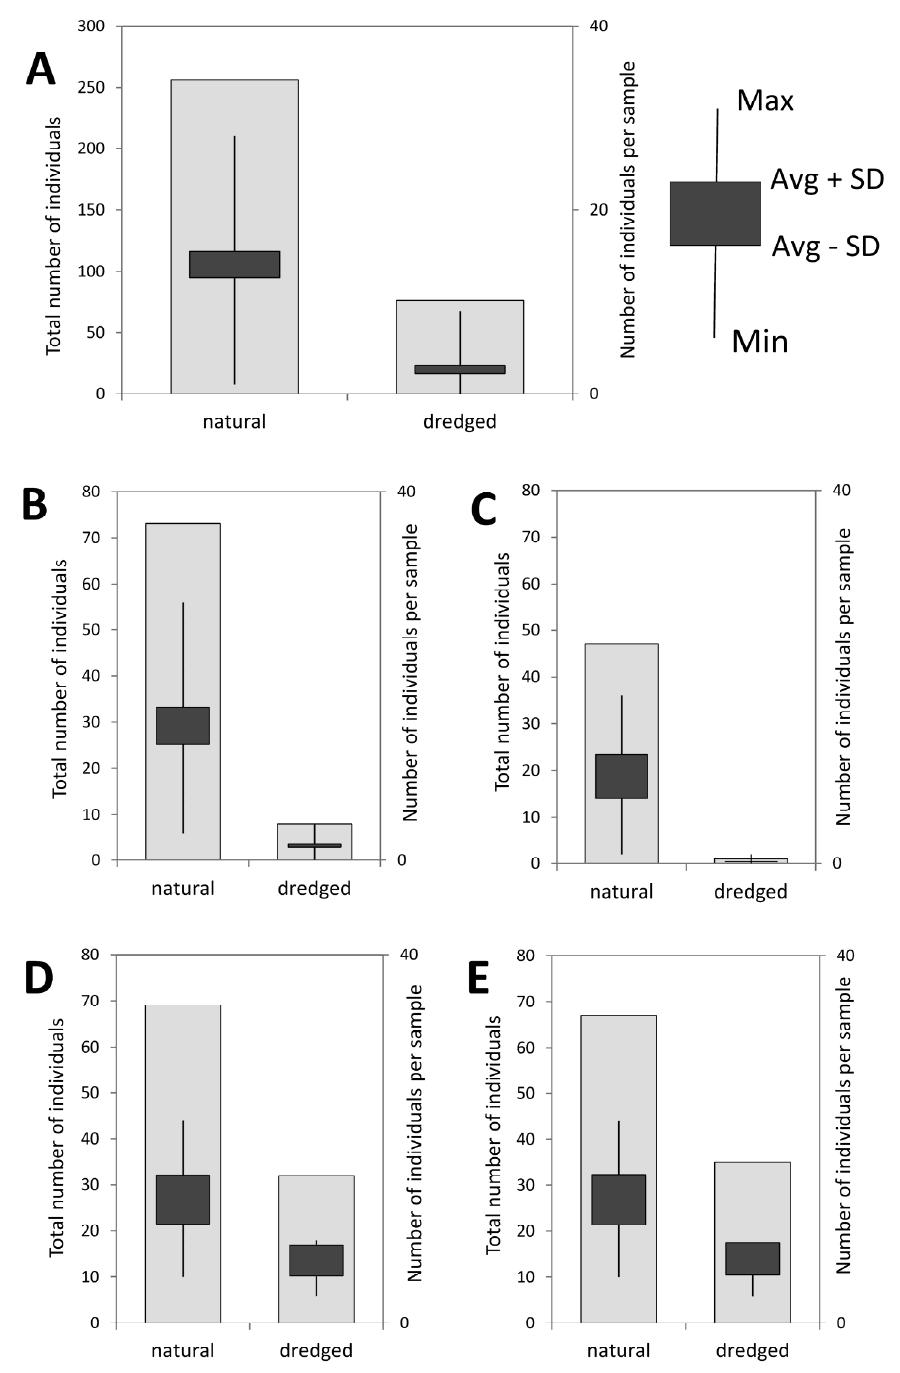
Figure 3. Comparison of abundance of macroinvertebrates between natural and dredged stretches: total number of sampled individuals and numbers of individuals per sample: ( A ) whole set of samples ( n = 20 + 20); ( B ) Ś lina river ( n = 5 + 5); ( C ) D ą b river ( n = 5 + 5); ( D ) Czaplinianka river ( n = 5 + 5); and ( E ) Turo ś nianka river ( n = 5 +